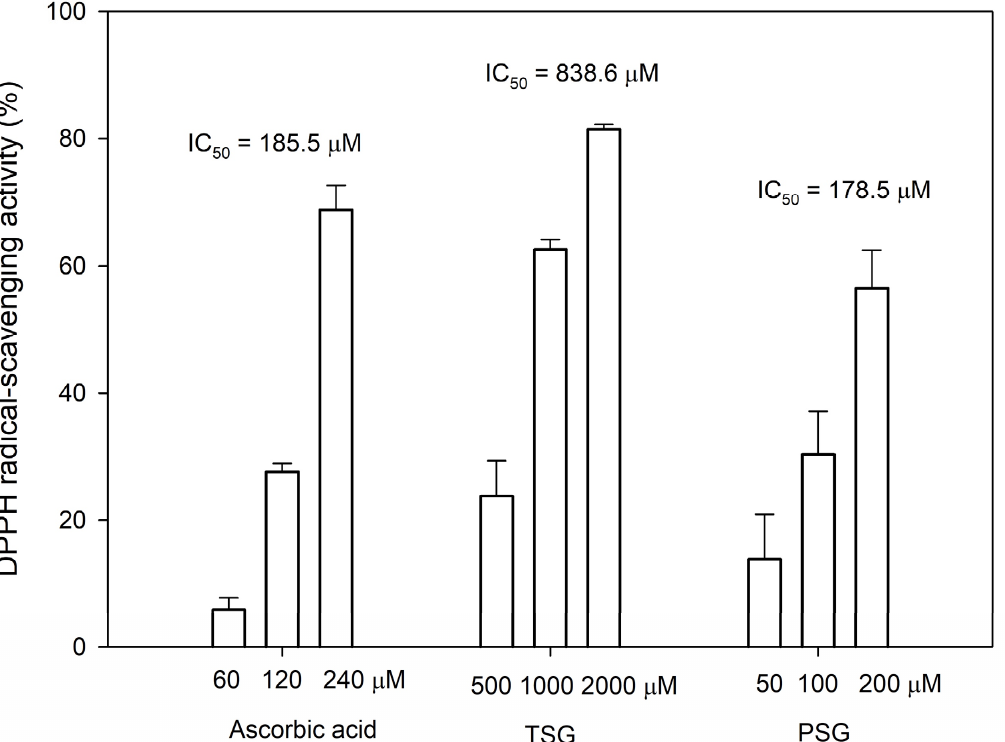
Figure 6. 1,1-Diphenyl-2-picrylhydrazine (DPPH) free radical-scavenging activity of TSG, PSG, and ascorbic acid. The DPPH scavenging activity was determined as described in Materials and Methods. The mean ( n = 3) is shown, and the standard deviation (S.D.) is represented by error bars. The IC 50 values represent the concentrations required for 50% DPPH free radical-scavenging activity.